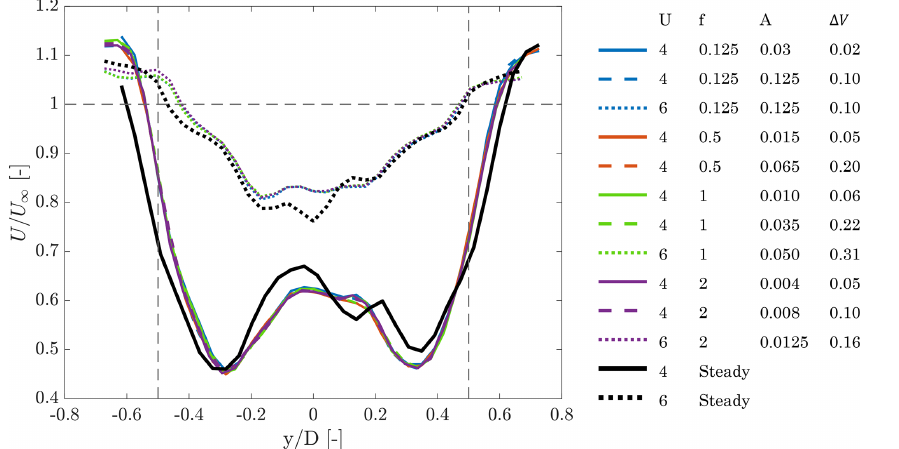
Figure 9. Mean velocity deficit at hub height ( y/D = 0 corresponds to the hub location, and the rotor edge is marked by the vertical dashed lines) for the steady cases (i.e., without surge motion) and unsteady cases. In the legend U is the mean wind speed, f the surge frequency, A the surge amplitude, and (cid:49)V the maximum surge